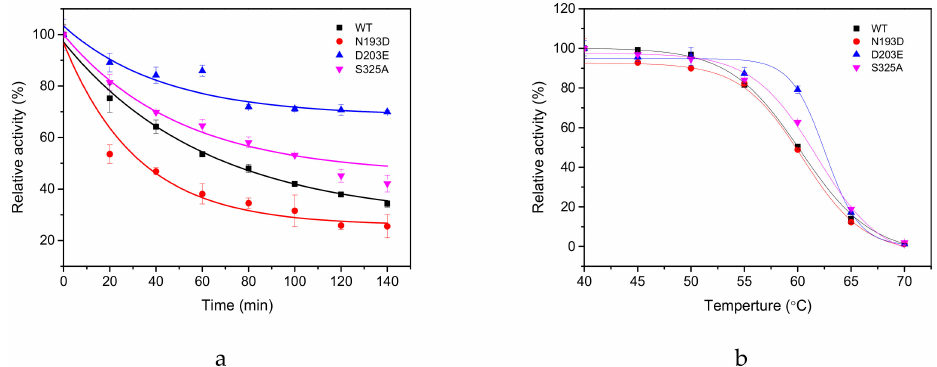
Figure 3. Stability analysis of WT and its mutants. ( a ) Thermal inactivation half-life (t 1 / 2 ) of WT and its two mutants at 55 ◦ C. ( b ) The thermal deactivation of wild-type GAD and the mutants at various temperatures for 15 min (T 50 15 ). The enzyme activity of each without heat treatment was assumed to be